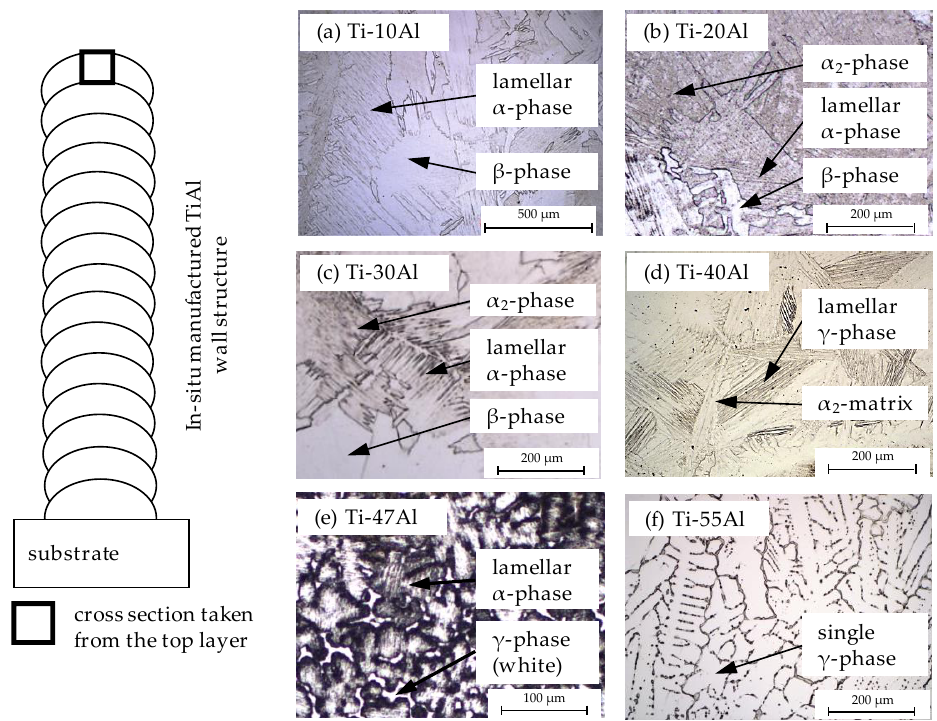
Figure 5. Analysis of the microstructure for Ti – Al alloys with differing aluminum content of (a) 10 at%, (b) 20 at%, (c) 30 at%, (d) 40 at%, (e) 47 at%, (f) 55 at%.